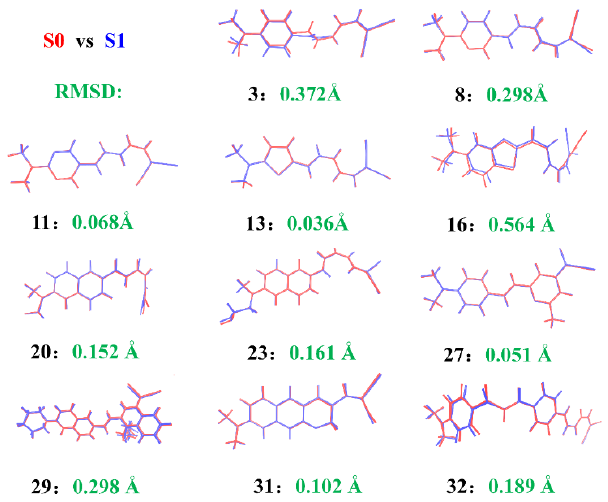
Figure 7. Geometrical comparison between the ground state (in blue) and the first excited state (in (in red) with RMSD values for selected probes in A β . red) with RMSD values for selected probes in A β .